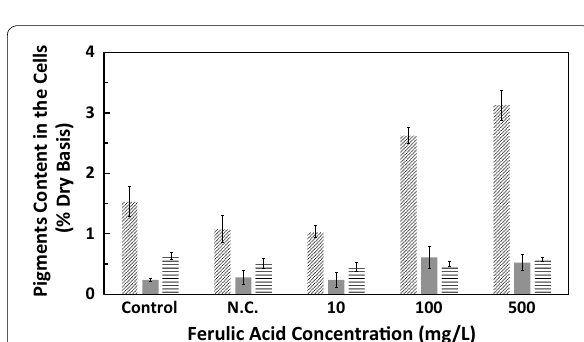
Fig. 4 Pigments content in Euglena gracilis cells cultured with dif‑ ferent concentrations of ferulic acid. N.C. negative control group. Symbols correspond to (square with upper right to lower left fill) chlorophyll a, (black square) chlorophyll b, (square with horizontal fill)